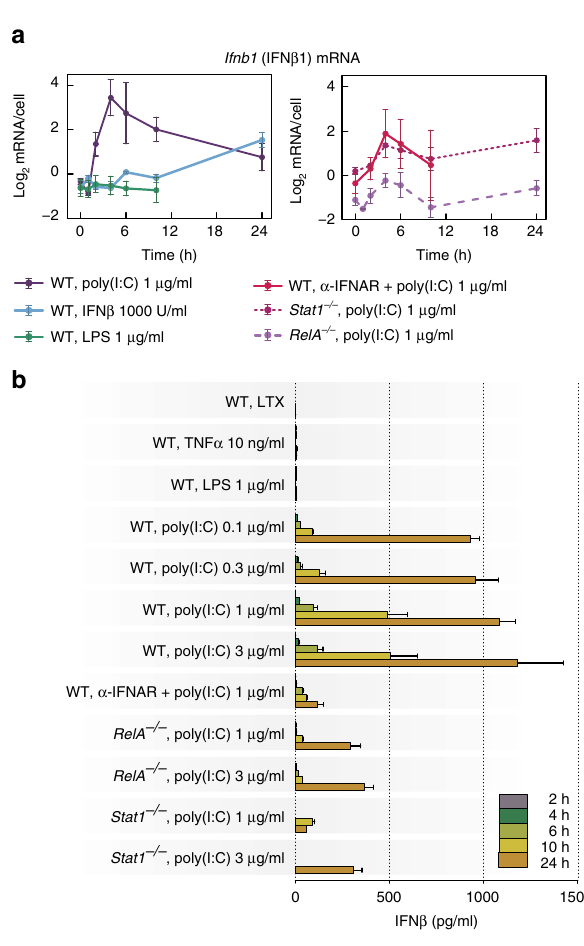
Fig. 3 Transcriptional activation and secretion of IFN β . a Time pro fi les of Ifnb1 (INF β ) mRNA levels in response to different stimuli. WT MEFs were stimulated with 1000U/ml IFN β , 1 μ g/ml LPS, or 1 μ g/ml poly(I:C) in the absence (left) or presence (right) of IFNAR-blocking antibody ( α -IFNAR). Stat1 – / – MEFs and RelA – / – MEFs (right) were also stimulated with 1 μ g/ml poly(I:C). α -IFNAR was added to cells at 10 μ g/ml at 0, 3, 6 and 10 h after poly(I:C) transfection. Time pro fi les of relative mRNA levels were obtained with RT-PCR, and then rescaled to absolute numbers using digital PCR measurements (bars represent means ± s.e.m., n ≥ 2; see Supplementary Note for plots of all replicates compared with model simulations). b Secretion of IFN β in response to TNF α , LPS or poly(I:C). WT MEFs were stimulated with 10 ng/ml TNF α ( n = 2), 1 μ g/ml LPS, 0.1, 0.3, 1 and 3 μ g/ml poly(I:C), or 1 μ g/ml poly(I:C) in the presence of α -IFNAR ( n = 2). Both Stat1 – / – MEFs and RelA – / – MEFs were stimulated with 1 μ g/ml or 3 μ g/ml poly(I:C). For each condition, IFN β concentration after 2, 4, 6, 10 and 24h was measured by ELISA in 200 μ l of culture medium harvested from above 25,000 ± 5000 cells. Bars represent means ± s.e.m. ( n = 3, except where stated otherwise, values of all replicates are provided in